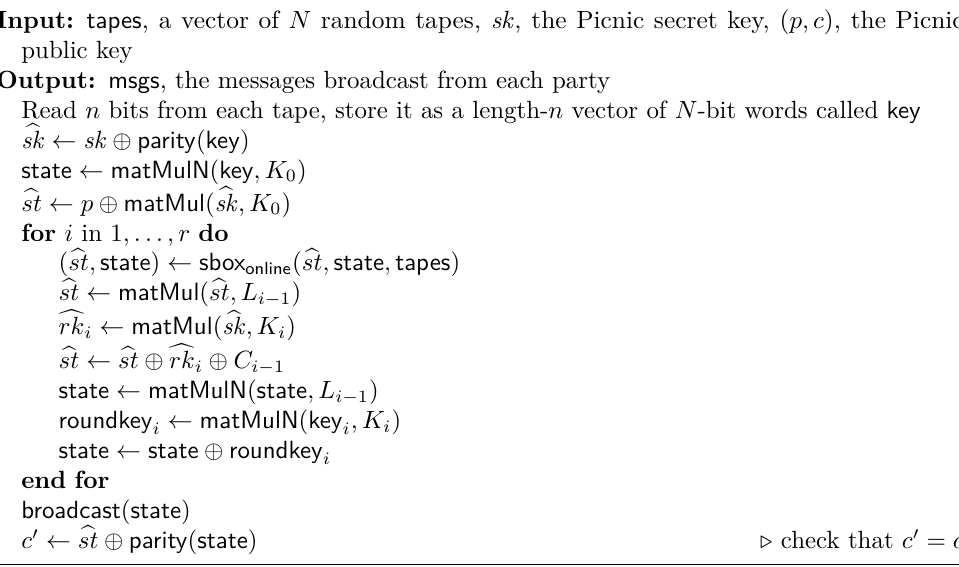
Algorithm 5 Simulation of Online Phase in Picnic2